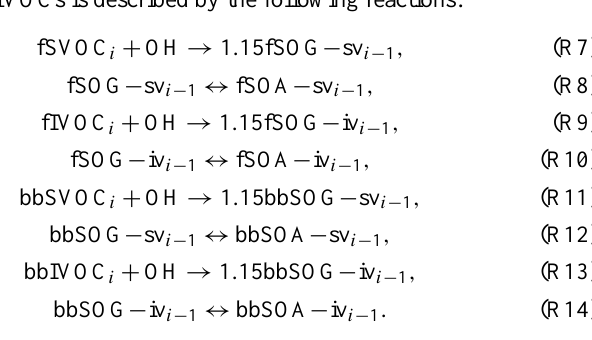
Table 6. Statistical evaluation of monthly averaged modeled OA against IMPROVE, EMEP, and East Asia observations during 2005–2009. Network Number of Mean observed Mean modeled MAGE MB NME NMB RMSE stations (µgm − 3 ) (µgm − 3 ) (µgm − 3 ) (µgm − 3 ) (%) (%) (µgm − 3 ) IMPROVE 193 a 1.93 3.02 1.71 1.09 89 57 EMEP 10 b 1.81 East Asia 18 c 11.02 5.53 a 10202 measurements. b 301 measurements. c 74